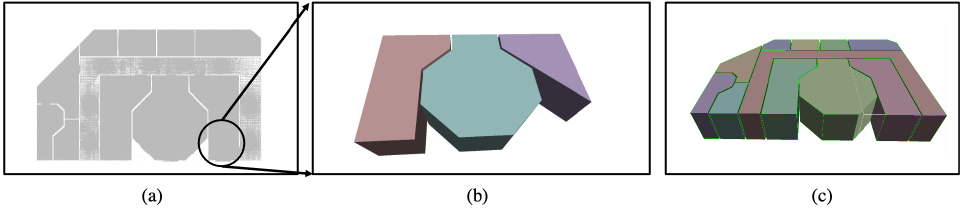
Figure 14. Raw point clouds [49] ( a ) and reconstructed results from Polyfit [30] ( b ) and the TC-SM ( c ). It shows that Polyfit failed to model right structural information (in middle circle), while the TC-SM method generates correct results,